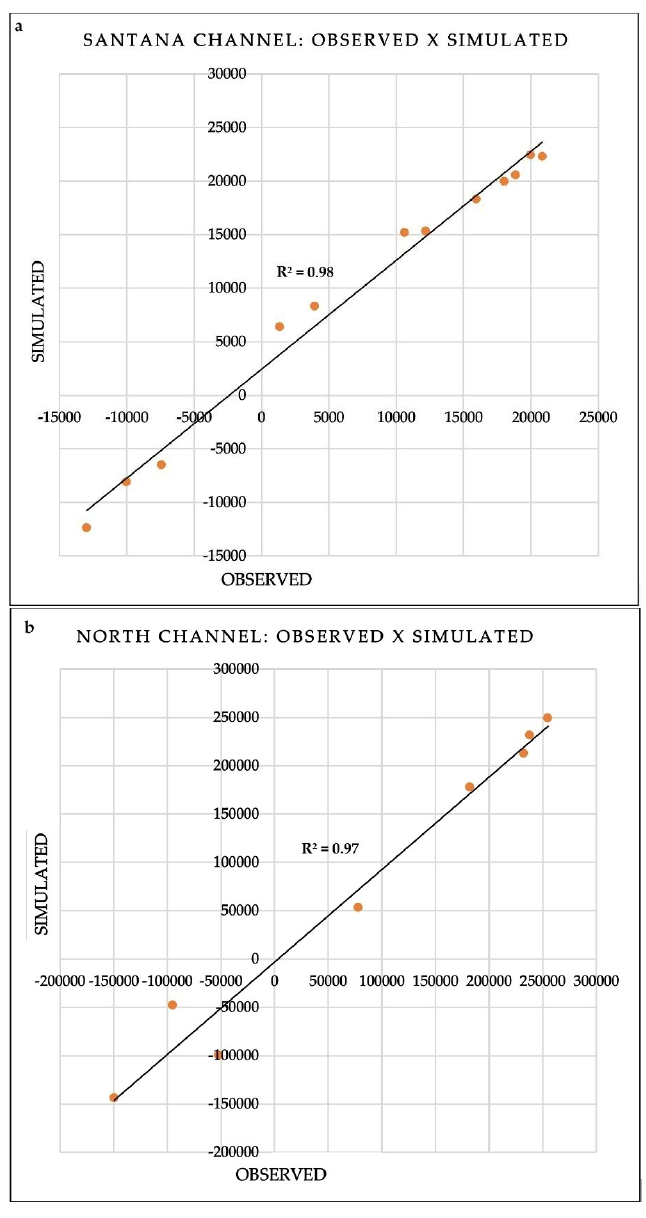
Figure 7. Correlation between simulated and experimental synchronize water discharge: ( a ) Santana Channel and( b ) North-MacapáChannel.